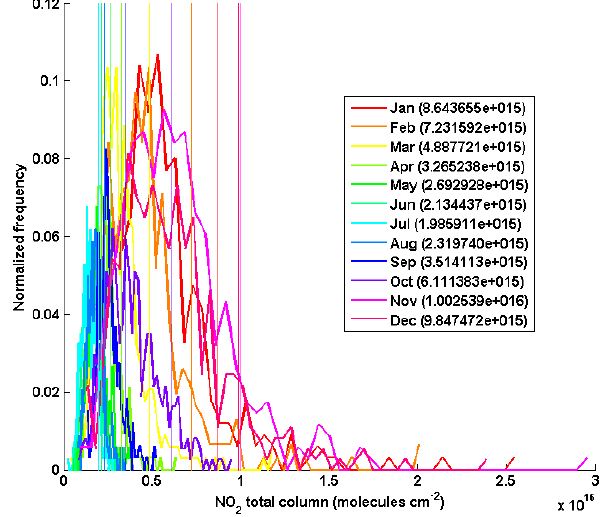
Figure 2. Monthly histograms of tropospheric total column NO 2 over the centre of the study area (55–60 ◦ N, 11–20 ◦ E) and corre- sponding 90th percentile thresholds (shown by vertical lines and values in